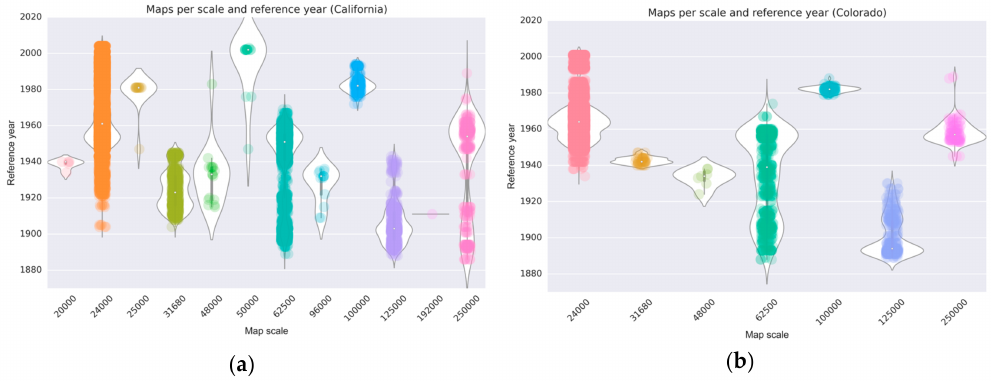
Figure 5. Produced USGS topographic maps per reference year and map scale ( a ) in California, and ( b ) in Colorado